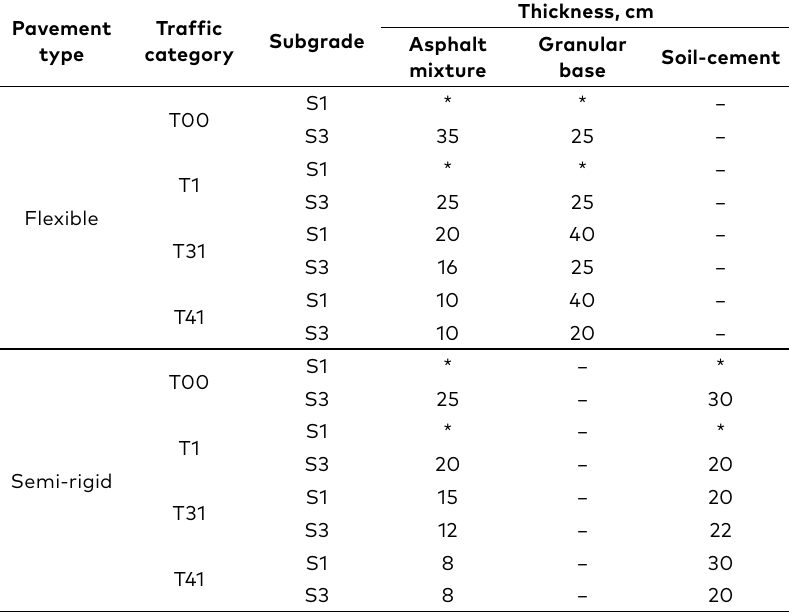
Table 3. Pavement sections studied